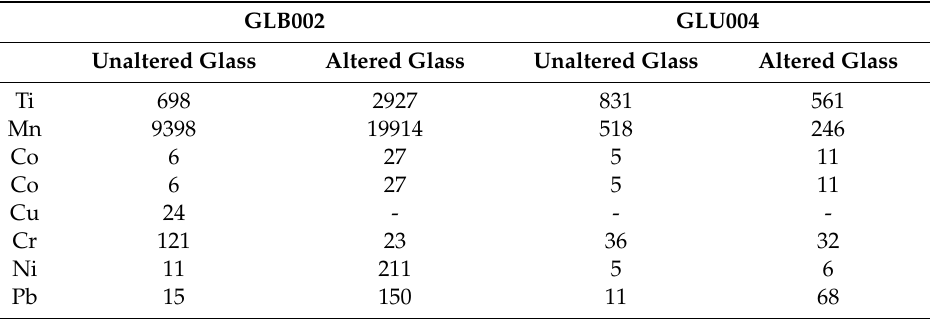
Table 3. Average concentration resulted from four analyses by LA-ICP-MS (expressed in ppm) of the most representative chemical elements, both on unaltered and altered glass for samples GLB002 and GlU004